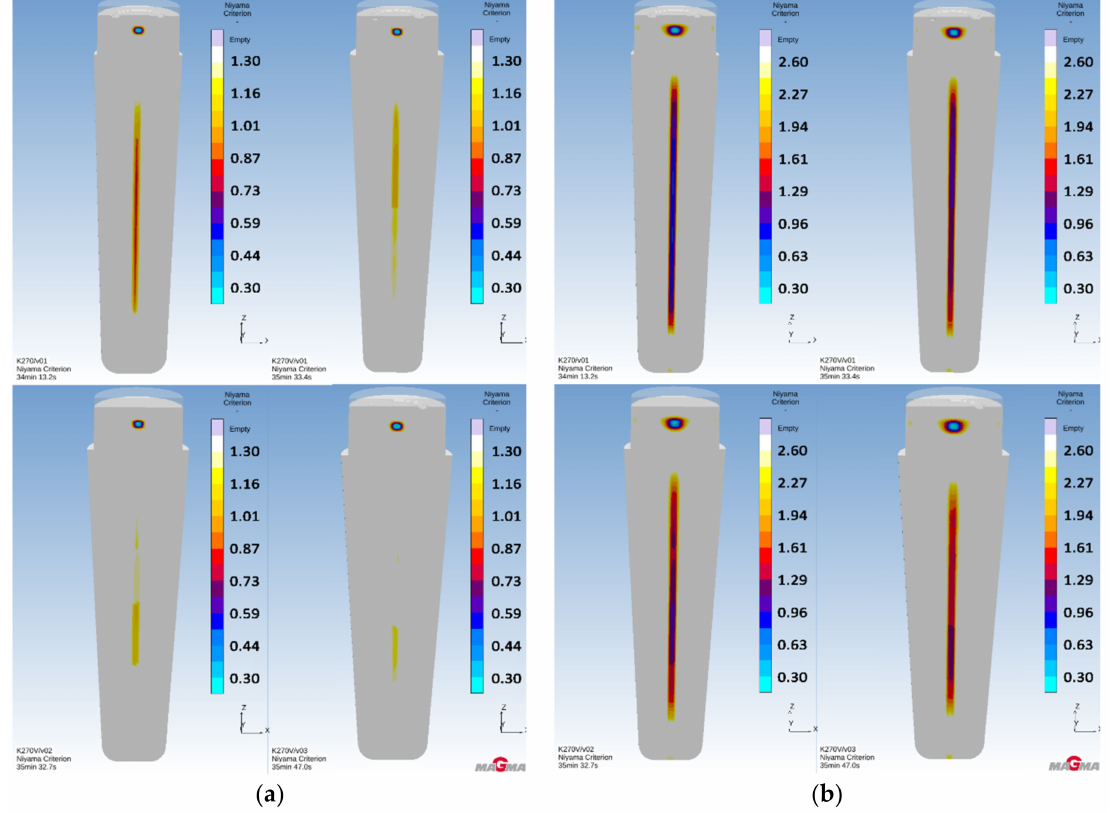
Figure 1. ( a ) Prediction of macroporosity—Ny 0.3–1.3, Height to Diameter (H/D) = 4.25, draft angle 2 ◦ (upper left), H/D = 4.25, draft angle 2.3 ◦ (upper right), H/D = 3.9, draft angle 2.5 ◦ (lower left), H/D = 3.5, draft angle 2.5 ◦ (lower right); ( b ) Prediction of microporosity—Ny 0.3–2.6, H/D = 4.25, draft angle 2 ◦ (upper left), H/D = 4.25, draft angle 2.3 ◦ (upper right), H/D = 3.9, draft angle 2.5 ◦ (lower left), H/D = 3.5, draft angle 2.5 ◦ (lower